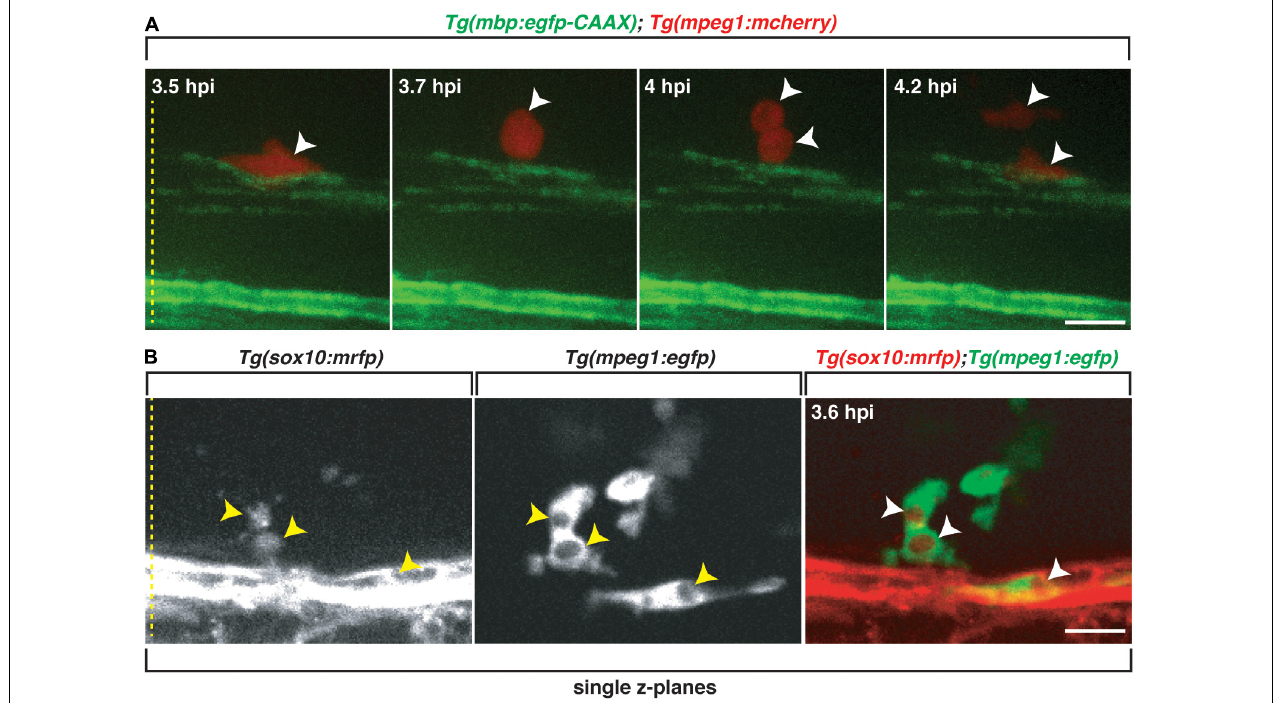
FIGURE 6 | Professional phagocytes proliferate and clear Sox10 + debris. All images are lateral views of the spinal cord with anterior to the left and dorsal to the top. (A) Following injection of lysolecithin into a 4 dpf zebrafish spinal cord, a mCherry + phagocyte recruited to the lysolecithin lesion proliferates (arrowheads). (B) Following injection of lysolecithin into a 6 dpf zebrafish spinal cord, sox10 + debris is cleared by an mpeg + cell. Arrowheads identify the sox10 + debris within mpeg + vacuoles in single z-planes. Yellow dashed lines denote the spinal cord. Scale bars, 25 µ